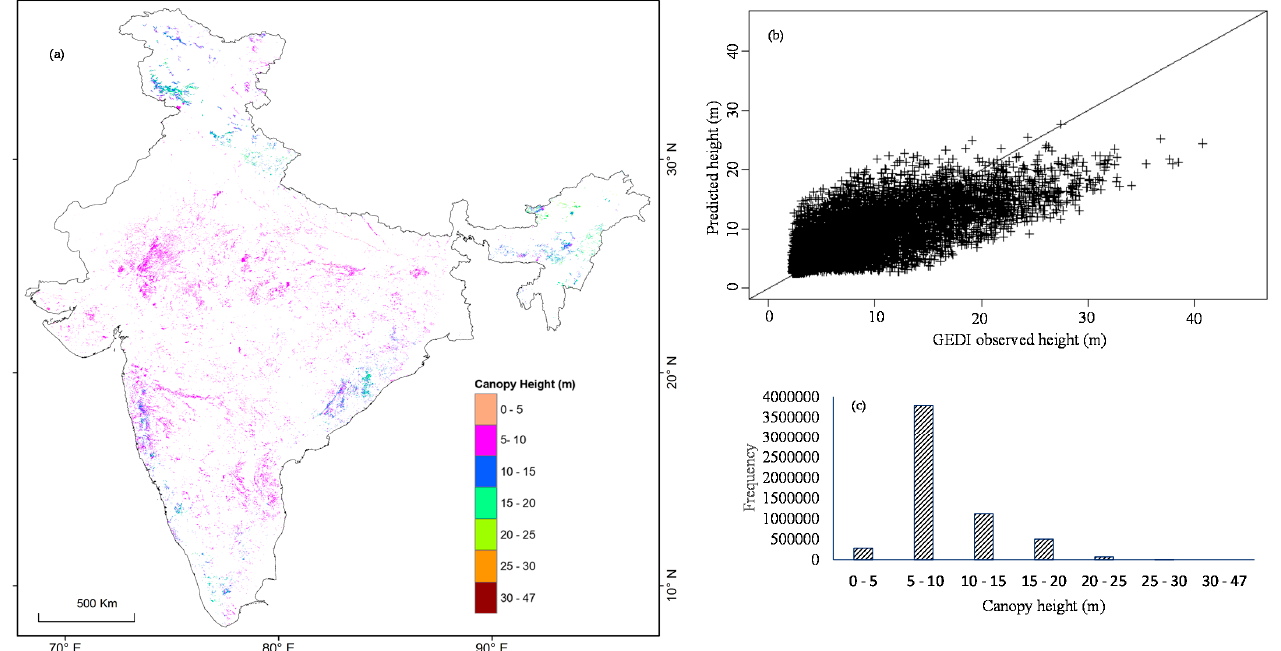
Figure 7. ( a ) GEDI predicted forest canopy height map, ( b ) the RF model predicted vs. the field- estimated height plot using the GEDI data and ( c ) histograms showing the canopy height distribution for the shrubland.